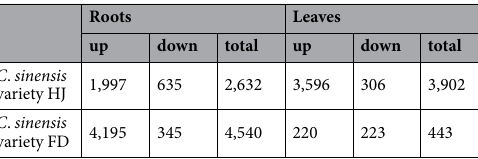
FD, respectively. In HJ, 1,639 (8.45%) unigenes were enriched in the pathways of amino acid metabolism com- pared to 1,627 (8.96%) unigenes in FD (Fig. S2). Differentially expressed genes in response to ammonium. The differentially expressed genes (DEGs) were measured according to the RNA-seq reads’ abundance and were normalized to fragments per kilobase length per million reads (FPKM). After ammonium treatment, 1,997/635 DEGs were up/down-regulated in the roots while 3,596/306 DEGs were up/down-regulated in the leaves of HJ. Meanwhile, 4,195/345 DEGs were up/ down-regulated in the roots while 220/223 DEGs were up/down-regulated in the leaves of FD (Table 1). More